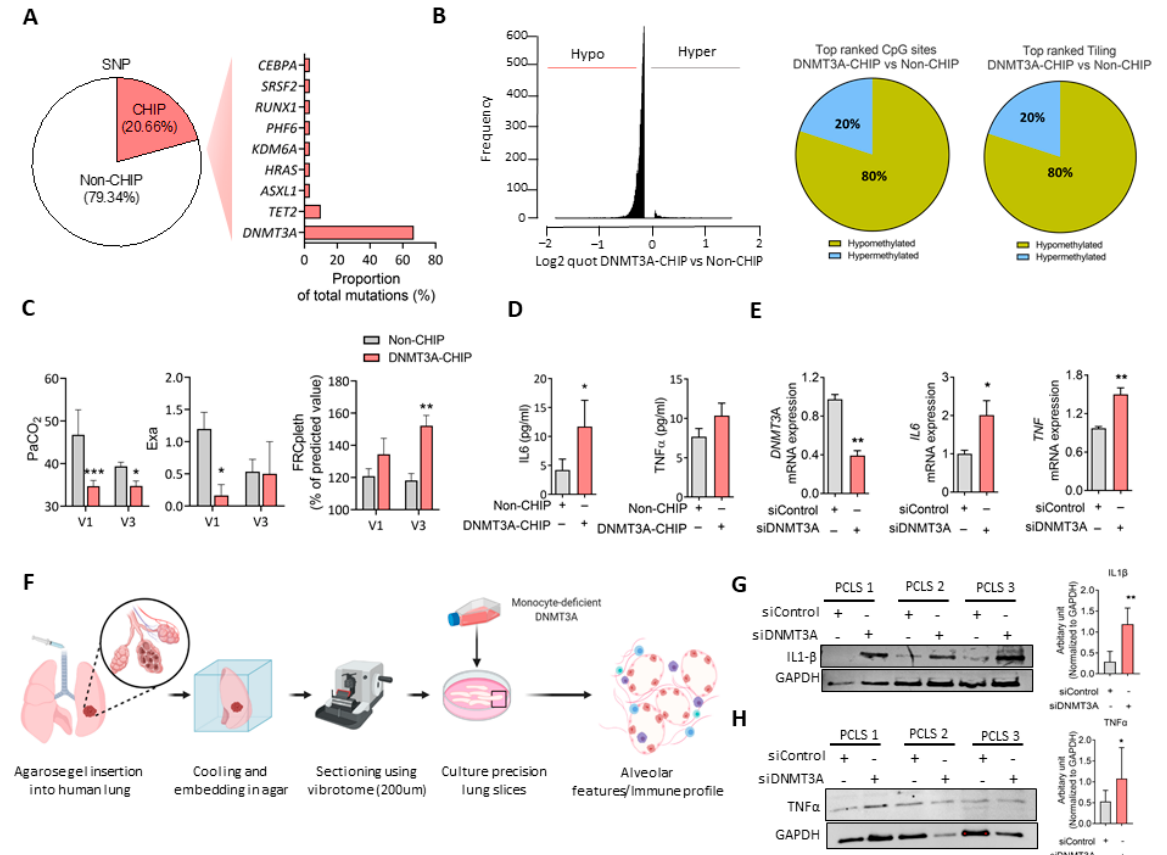
Figure 1. Clonal hematopoiesis of indeterminate potential (CHIP) and mutations in DNMT3A gene is prevalent in COPD patients. ( A ) The % of CHIP mutation carriers and the proportion of CHIP- associated mutations (in 56 analyzed genes) in patients with COPD is given. ( B ) Distribution of hypomethylated (Hypo) and hypermethylated (Hyper) CpG sites in DNMT3A-CHIP and Non-CHIP patients as well as the depiction of the methylation status of top-ranked CpGs and tiling sites in DNMT3A-CHIP COPD and non-CHIP COPD patients. ( C ) Lung function parameters FRCpleth, Exa and PaCO 2 in 26 early-stage patients with CHIP mutation (CHIP; n = 6) or without CHIP mutation (Non-CHIP; n = 20), observed over 1.5 years, are given. V1—first visit upon entry into the COSYCONET cohort; V3—third visit after 18 ± 1 months. ( D ) Plasma IL6 and TNF α levels in CHIP ( n = 6 for IL6 and TNF α ) and Non-CHIP patients ( n = 19 for IL6 and TNF α ) with early-stage COPD. p values are adjusted by confounding factors including age, sex, smoking status, and pack years. ( E ) mRNA expression of DNMT3A , TNF α , and IL6 in PBMC-derived monocytes, that were subsequently differentiated into macrophages and are transfected with siControl (non-silencing control siRNA) and siDNMT3A for 48 h ( n = 3 independently performed experiments) to mimic the hypomethylation status observed by DNMT3A SNPs in COPD, 2-tailed Student’s t test. ( F ) Schematic presentation of ex vivo cultured human PCLS with conditional media of DNMT3A deficient monocyte cell line (THP1), that was transfected with siControl (non-silencing control siRNA) and siDNMT3A for 48 h. ( G , H ) Representative western blotting images of IL1 β and TNF α followed by densitometric quantification of relative expression IL1 β and TNF α with GAPDH as the loading control in PCLS ( n = 5), 2-tailed Student’s t -test. p values are adjusted by confounding factors including age, sex, smoking status, and pack years. PaCO 2 —Partial pressure of carbon dioxide in mmHg. FRCpleth—functional residual capacity measured by body plethysmography. Exa—exacerbations. *: p < 0.05, **: p < 0.01, ***: p < 0.001.